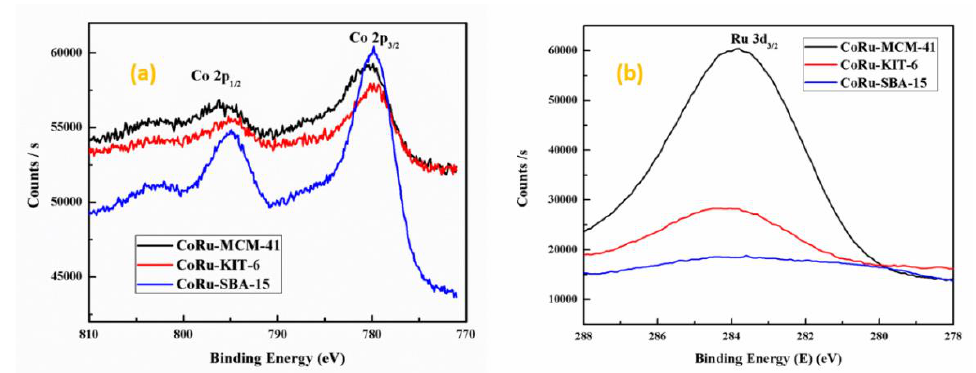
Figure 5. XPS spectra of metals incorporated MCM-41, KIT-6, and SBA-15: ( a ) Co 2p spectra and ( b ) Ru 3d